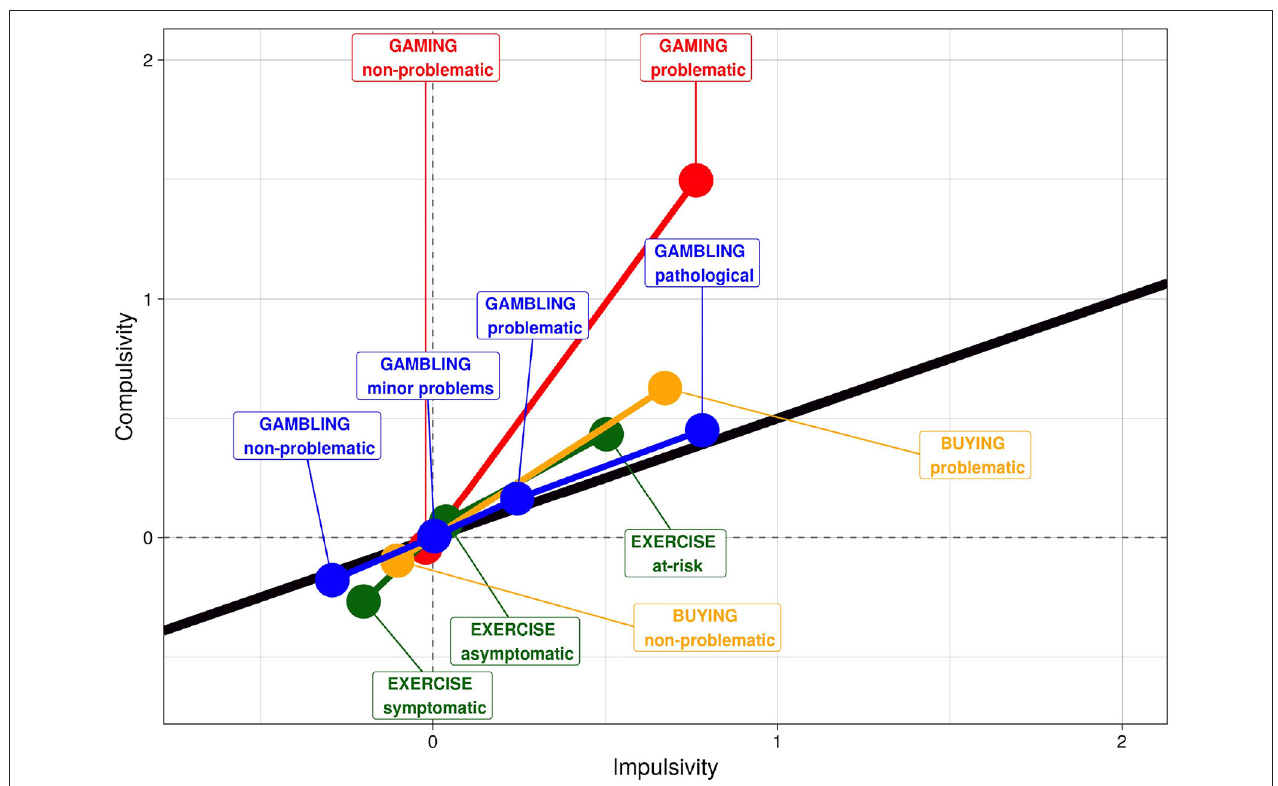
FIGURE 2 | Impulsivity and compulsivity within problem groups in specific samples. Impulsivity and compulsivity scores were standardized within the sample, and the standardized values are present in the Figure. The solid black line indicates the (theoretical) position when compulsivity and impulsivity are equally present in the given group. Values above the solid line indicate the dominance of compulsivity, whereas group means below the line indicate the dominance of